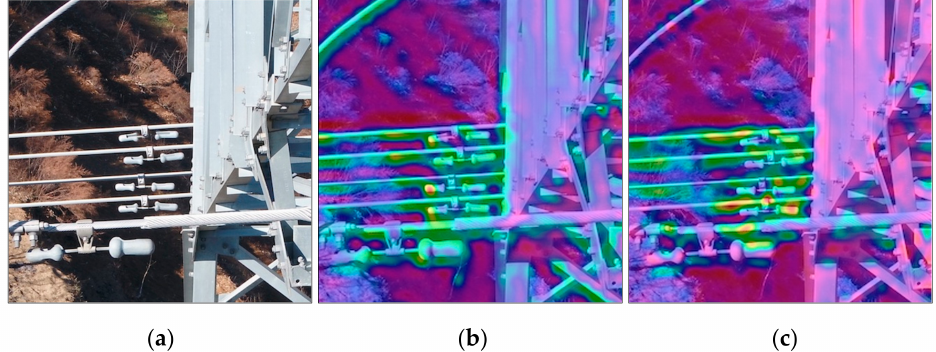
Figure 13. Grad-CAM results from YOLOv4 combined with different attention modules: ( a ) original image; ( b ) CBAM; ( c )